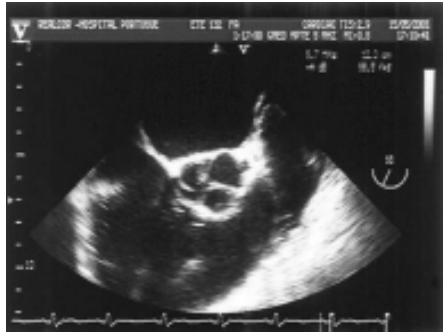
Fig. 3 – Aspect of the transoesophageal echocardiogram, showing rupture of the non-coronary aortic cuspid